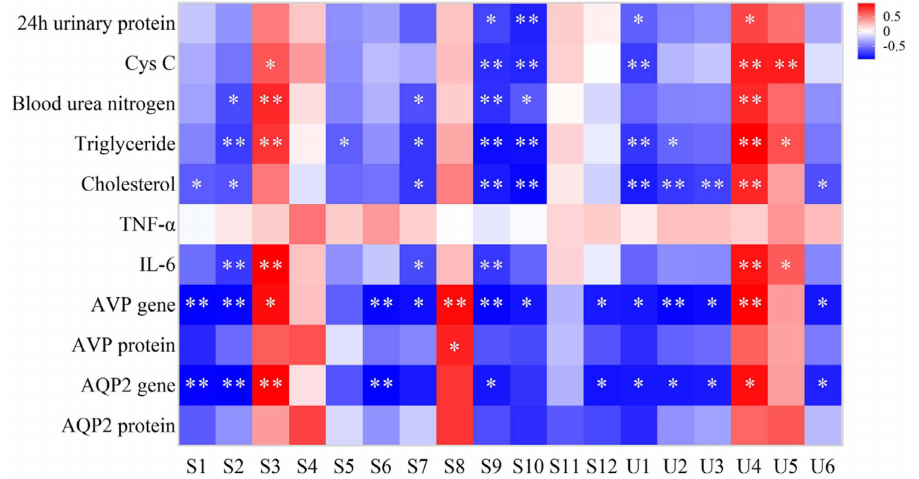
Figure 9. Association plot of rat serum and urine metabolites and efficacy indicators according to Pearson correlation coefficient. The degree of correlation is shown on a color scale from significant negative correlation (blue) to significant positive correlation (red). S1~S12 are cysteine, lactic acid, L-methionine, L-isoleucine, valine, glycine, citric acid, pyruvic acid, succinic acid, respectively. L- aspartic acid, lactose, and maltose; U1~U6 are glycine, pyruvic acid, glutaric acid, adipic acid, uric acid, and 4-pyridoxic acid, respectively. * and ** indicate significant correlation at 0.05 and 0.01 levels (double tails),